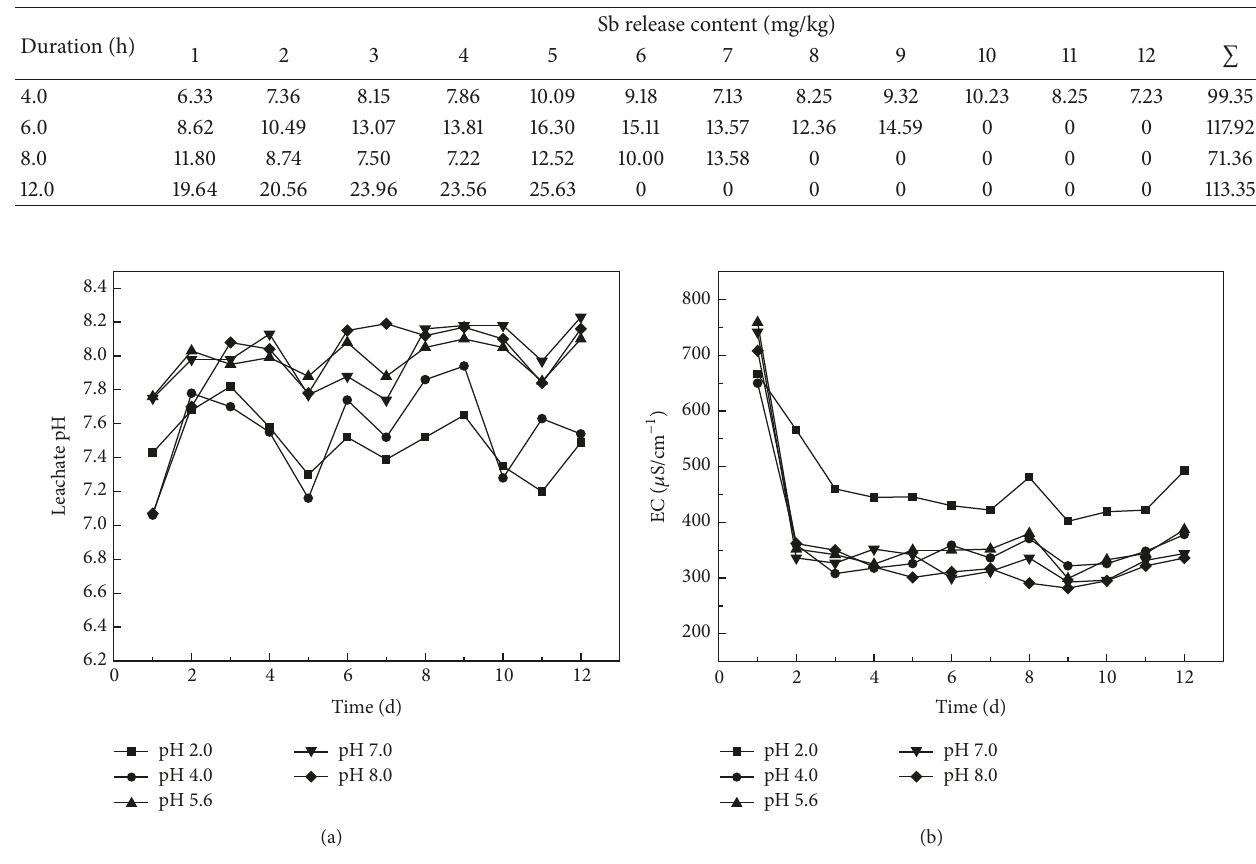
Table 2: Cumulative release amount of Sb in smelting slag under different rainfall duration.